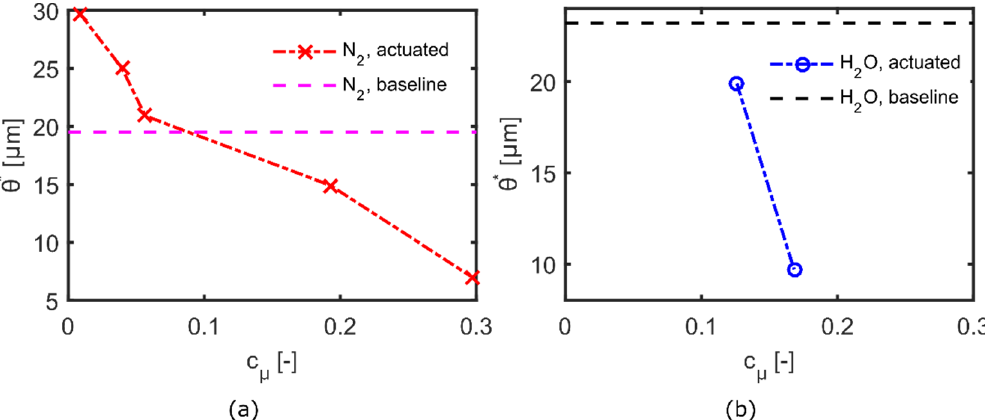
Figure 12. Momentum thickness along the width-wise direction θ xy at the exit section in the symmetry plane as a function of the overall momentum co-efficient of secondary injection c μ : ( a ) nitrogen gaseous flow; ( b ) water vapor flow.